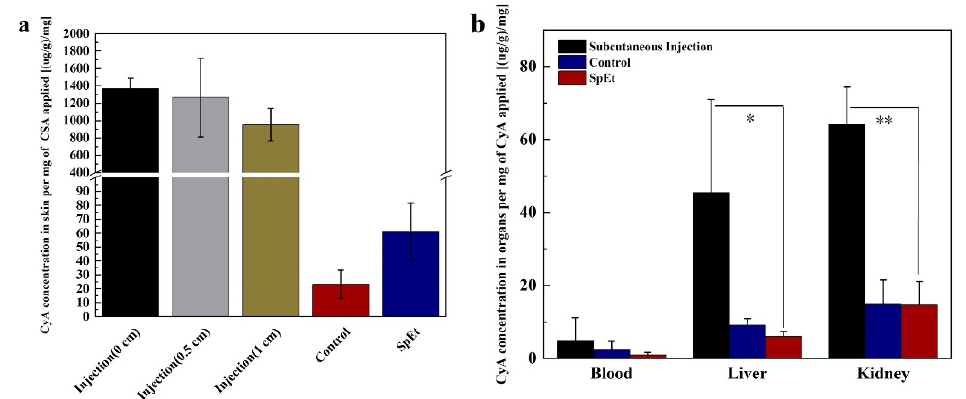
Figure 8. The combined use of ethosomes and SHS(SpEt) enhanced CysA skin penetration and reduced its systemic deposition in vivo. ( a ) The skin deposition of CysA induced by different treatments over 7 days in vivo. ( b ) Biodistribution of CysA induced by different treatments over 7 days in vivo. * represents p < 0.05, ** represents p < 0.01.